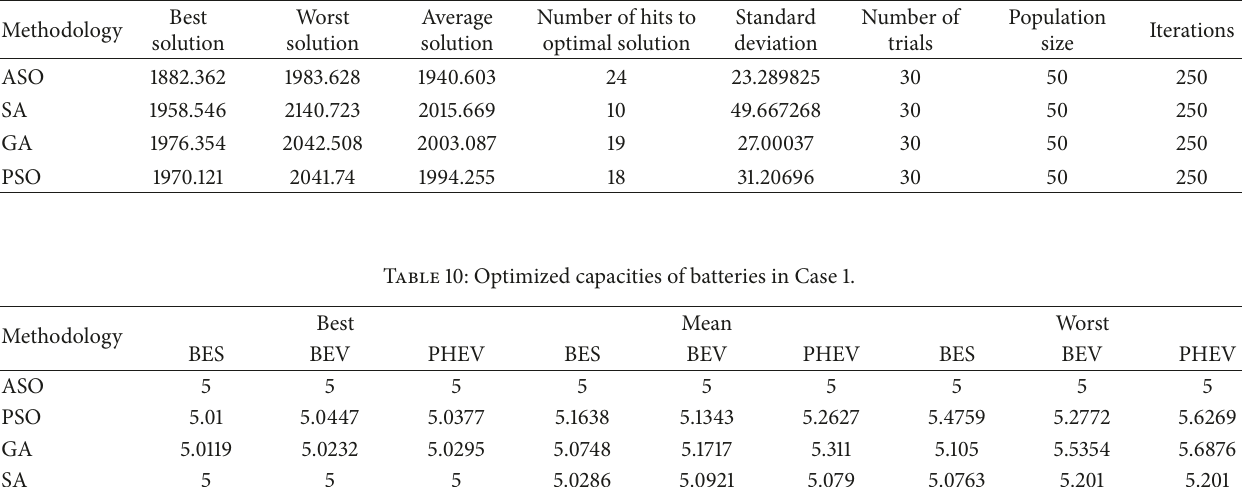
Table 9: Comparison of operation cost for Case 2 (30 trials), €ct/day.